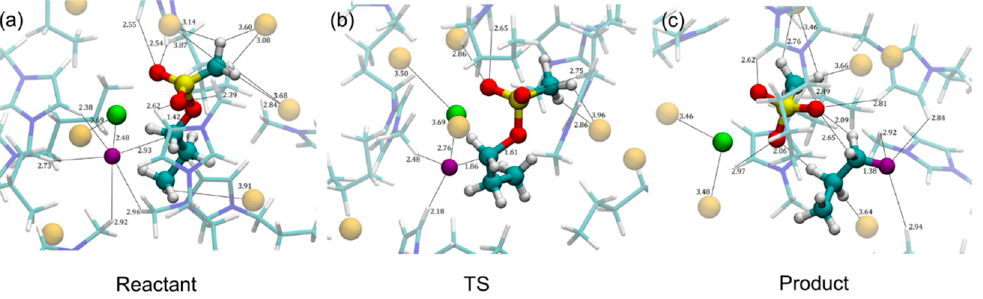
Figure 7. Molecular environment for the S N 2-[Bmim][Br] system at different kinetic states: ( a ) reactant, ( b ) transition state, and ( c ) product.